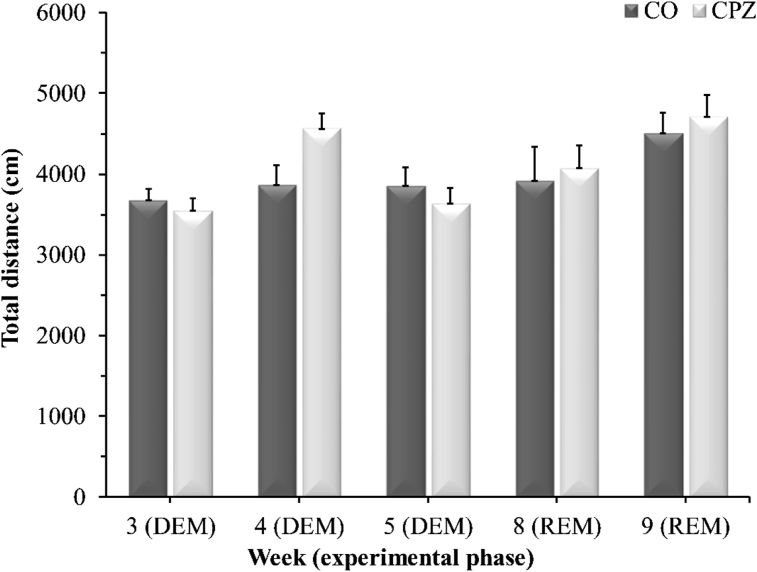
Open field test results. Data are presented as the total ambulation distance in the CO-, DEM- and REM groups. CO control group, CPZ cuprizone treated group, DEM demyelination phase in the treated group, REM remyelination phase in the treated group, n = 18/group.